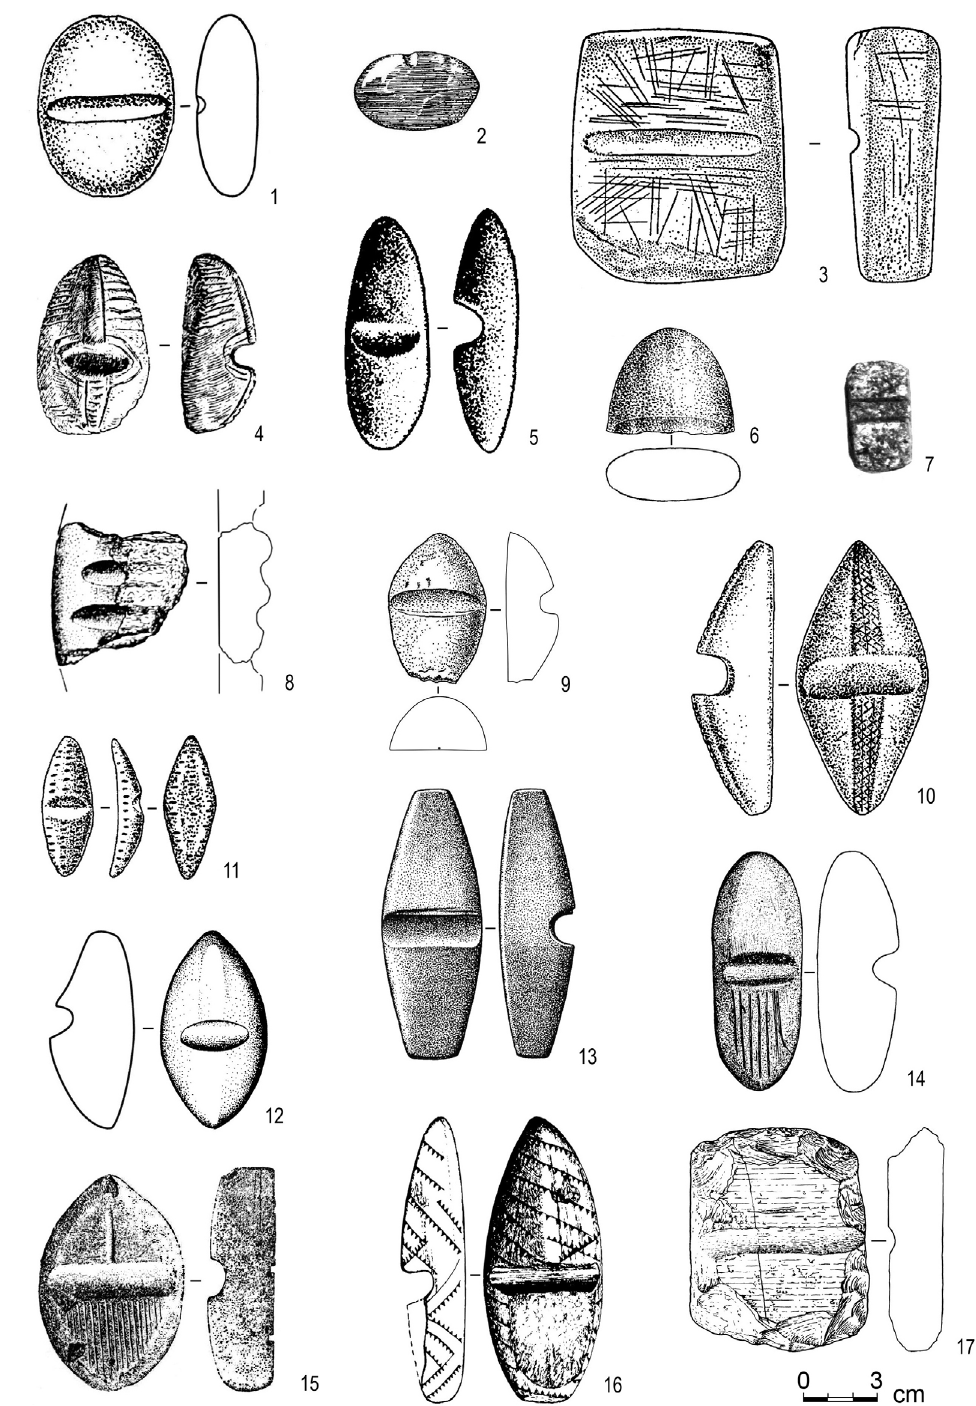
Figure 2. Transverse grooved artefacts from North Eurasia (1-10, 12-17 - stone; 11-ceramic.).1 - Central Asia, Lyavlyakan 340 (Vinogradov & Mamedov 1975: fig. 42, 2; 2 - Transcaucasia, Anaseuli I (Bzhaniya 1996: fig. 22, 49); 3 - Transcaucasia, Klady (Korobkova & Sharovskaya 1983: fig. 9, 12); 4 - Ukraine, Vovnigi levoberezhnye (Rudinskij 1956: fig. 10, 3); 5 - Ukraine, Vovnigi pravoberezhnye (Telegin 1968: fig.17, 1); 6 - Central Russia, Stanovoe 4 (M.G. Zhilin: personal communication); 7, 9 - Southern Urals, Berezki VIII (Usacheva 2013a: fig. 15, 3, 5); 8 - Southern Russia, Razdorskoe 2 (Cybrij 2004: fig. 2, 7); 10 - Middle Urals, 1- e Karas'e ozero (Viktorova & Kerner 1998: fig. 4, 3) 11 - Middle Urals, Palatki I (Viktorova & Kerner 1998: fig. 19, 9); 12 - Kazakhstan, Karaganda 15 (Klapchuk 1970: fig. 3, 17); 13 - Siberia, Borovyanka XVII (Hvostov 2001: fig. 1, 2); 14 - Kazakhstan, Bestamak (V.N. Logvin: personal communication); 15 - Siberia, Sopka 2 (Molodin 1992: fig. 41); 16 - Altai, Ust'-Isha (Kiryushin et al . 2000: fig. 25, 22); 17 - Mongolia, Zuuh 7 (Nohrina et al. 1996: